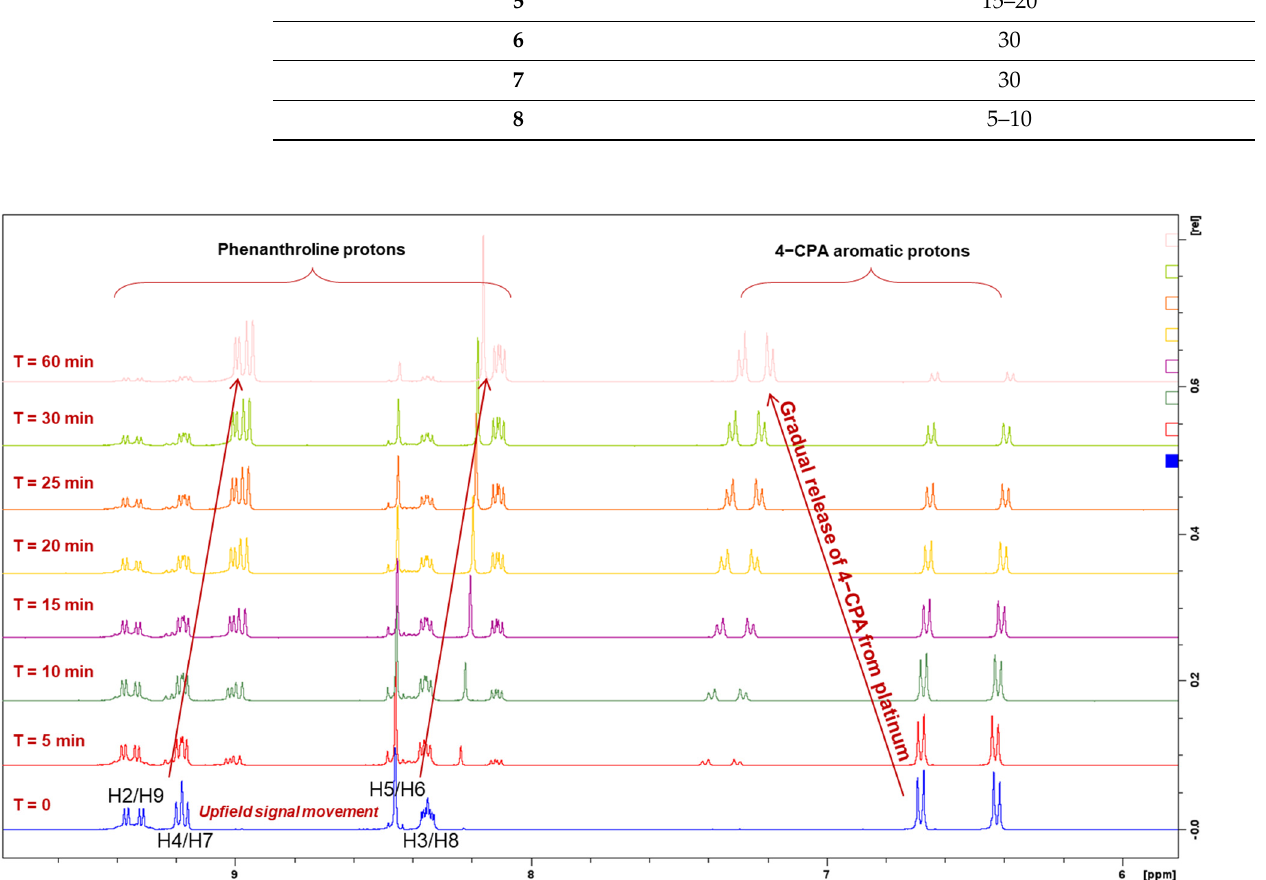
Figure 16. 1D − 195 Pt − NMR spectra of 1 with PBS and AsA in D 2 O, within the regions of − 2800 and 400 ppm at 37 °C, highlighting its complete reduction after 1 h after the final 1 H − NMR experiment.